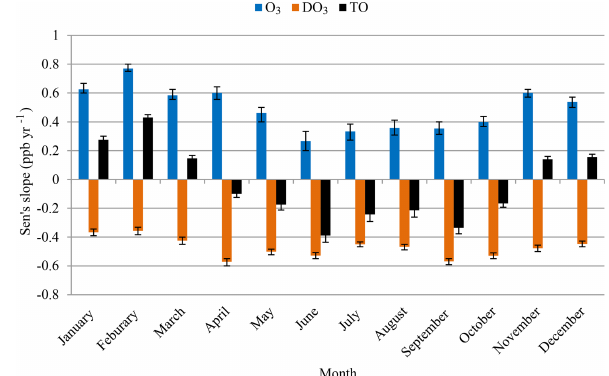
Figure 6. Monthly rates of change during 1996–2015 for O 3 , DO 3 , and